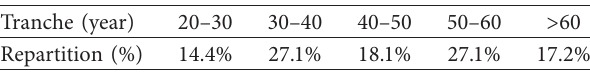
Table 1: Gender of participants. Table 2: Distribution by age.